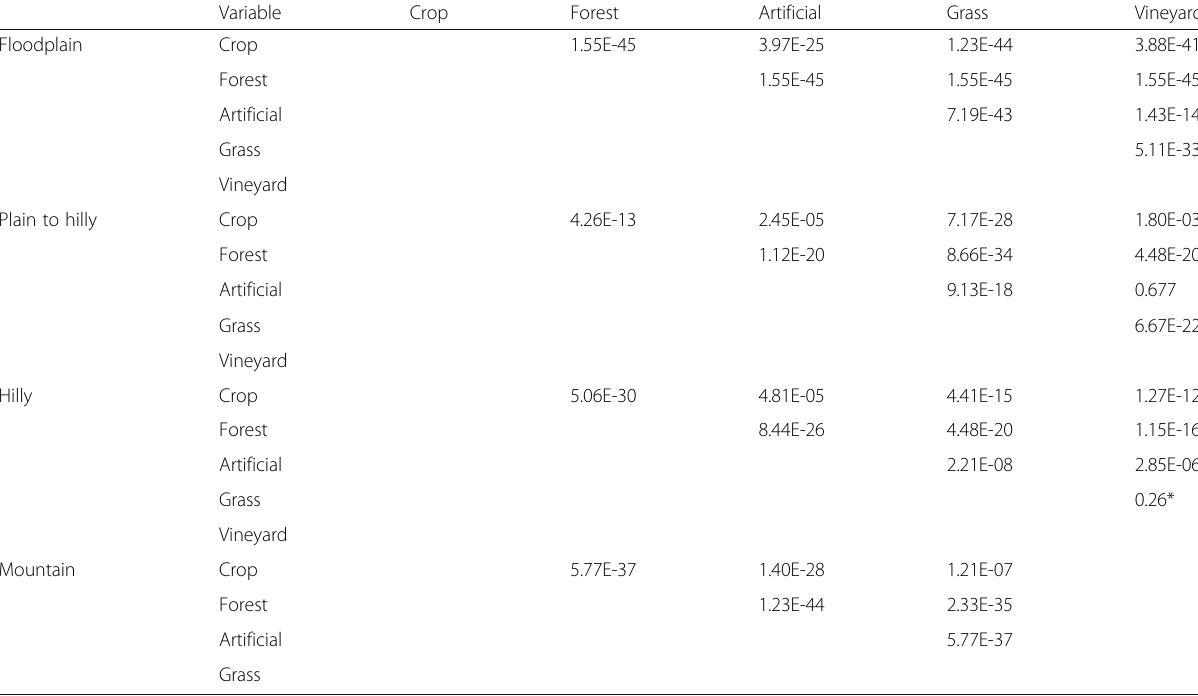
Table 7 The significant level of two-sample Kolmogorov-Smirnov test of pairwise differences in Spc between land covers within topographic